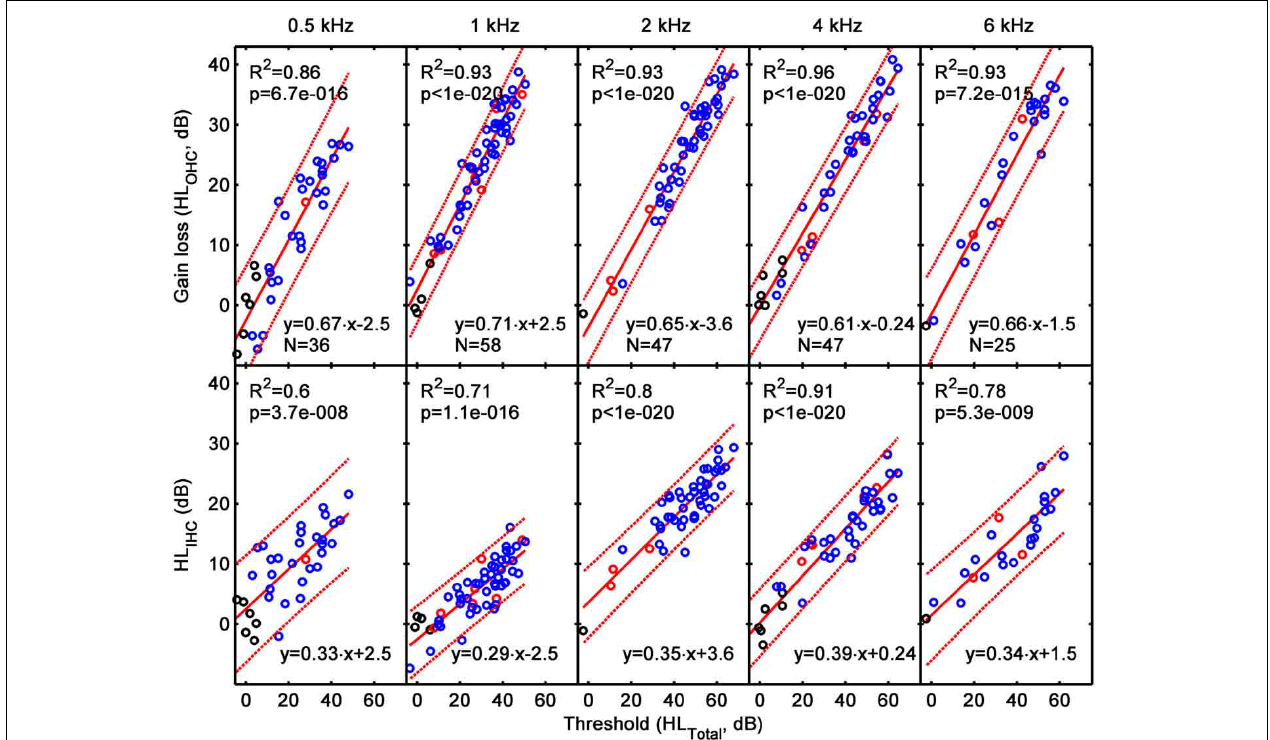
FIGURE 6 | The contribution of HL OHC (top) and HL IHC (bottom) to HL TOTAL assessed from the analysis of Type 1 I/O curves (i.e., from I/O curves with CT present). Each column is a for a different test frequency, as indicated by the column title. Results for the current hearing-impaired listeners are depicted as blue symbols; results for NH listeners and for